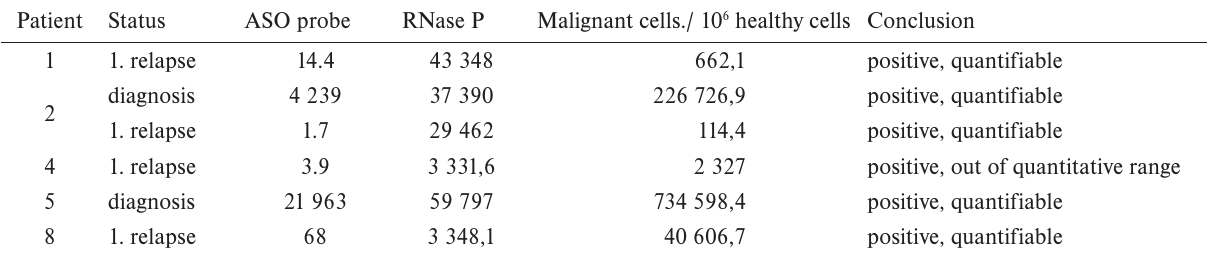
Table 4. Results of RQ-PCR detection of tumor-specific marker in